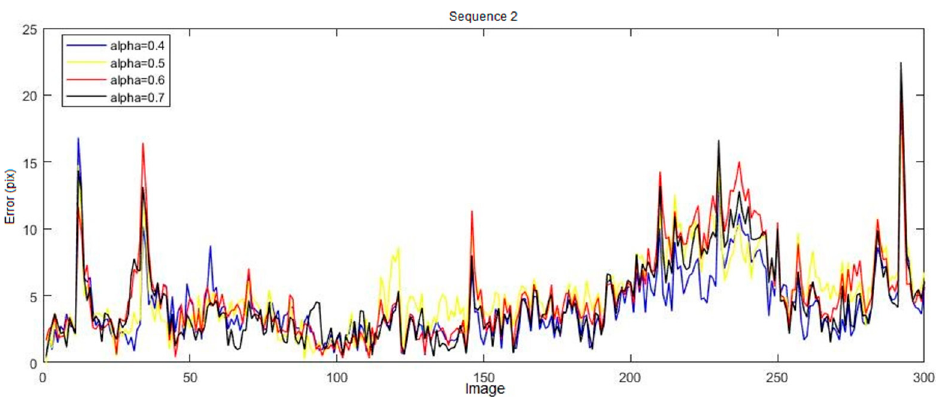
Figure 7. Influence of the parameter 𝛼 —sequence n° 2. The results suggest that a good choice for the alpha parameter can improve the performance of the annealed particle filter (APF) and consequently increase the accuracy of 3D tracking.